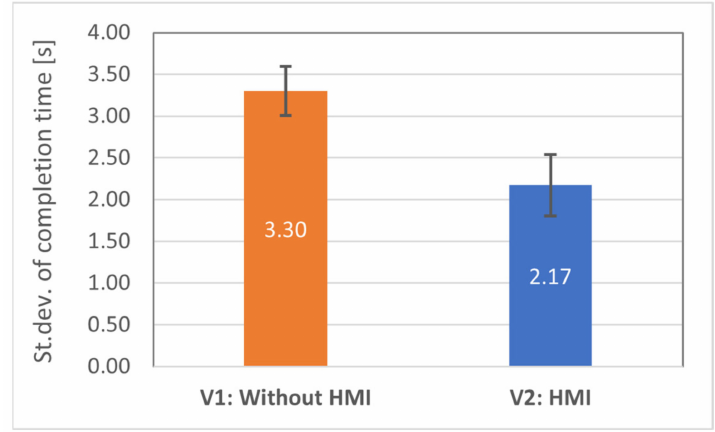
Figure 15. Standard deviations of the task completion time: lower is better. It is also anticipated that the effectiveness of the V2 and the baseline will be comparable; however, proving this hypothesis (basically null-hypothesis) with a high confidence level requires a large number of test subjects. The average task success rates with standard errors are shown in Figure 16. One of the factors that may have led to a lower success rate with the V2 interface may be that the haptic feedback (V2) did not provide the test subjects with enough spatial information, which led to an ambiguous determination of the goal